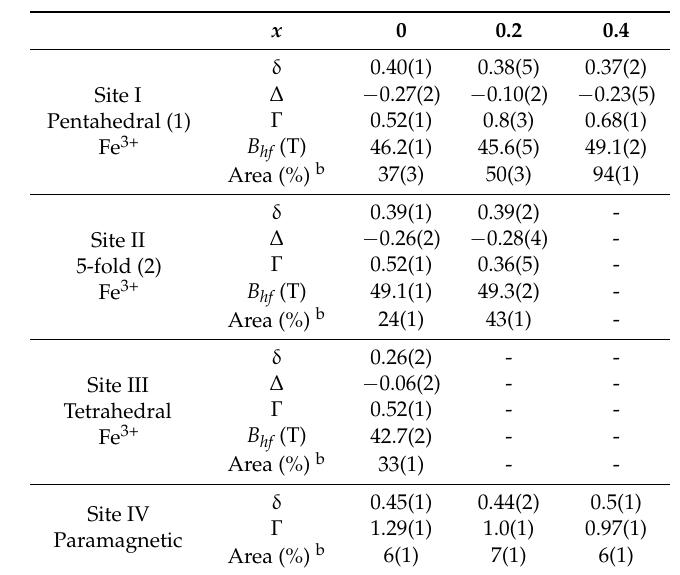
Table 5. Mössbauer spectral parameters of N 2 -annealed Sr 3 − x Pr x Fe 1.25 Ni 0.75 O 7 − δ phases below their magnetic transition temperature a .